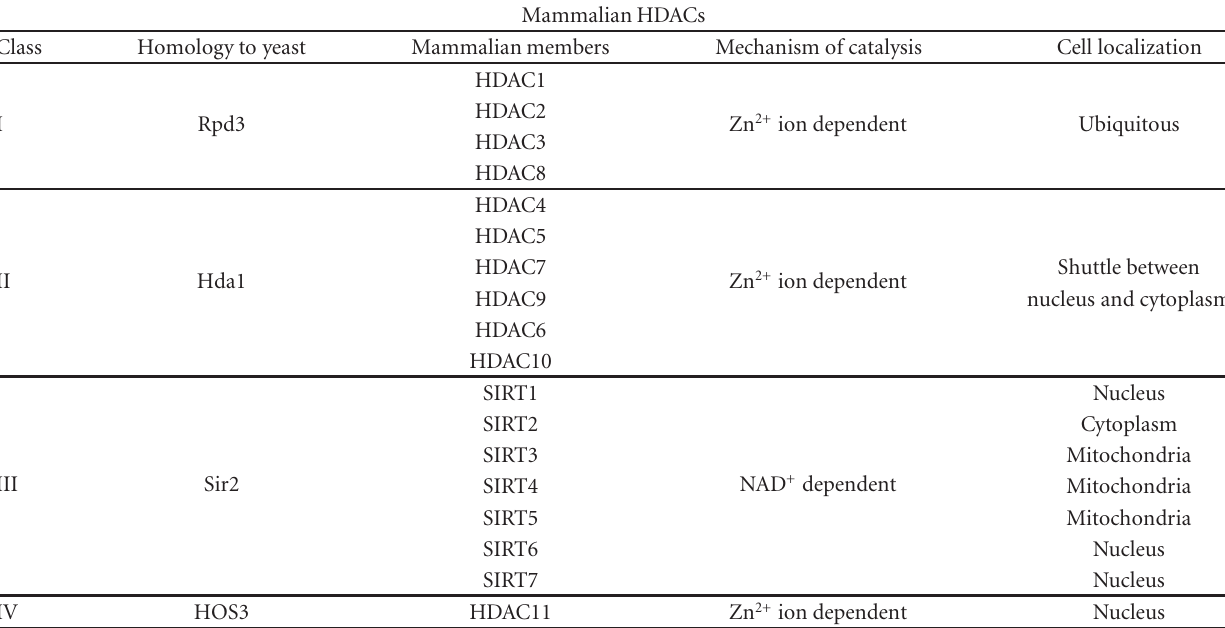
Table 2: Mammalian Members of HDAC